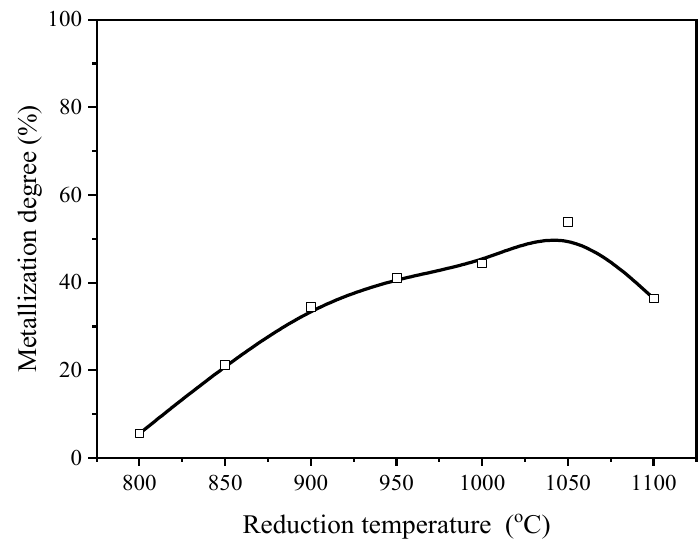
Figure 4. Effect of reduction temperature on metallization degree of reduced pellets of high-aluminum iron ore (HA ore) (reducing for 60 min with C/Fe mass ratio of 1.5).